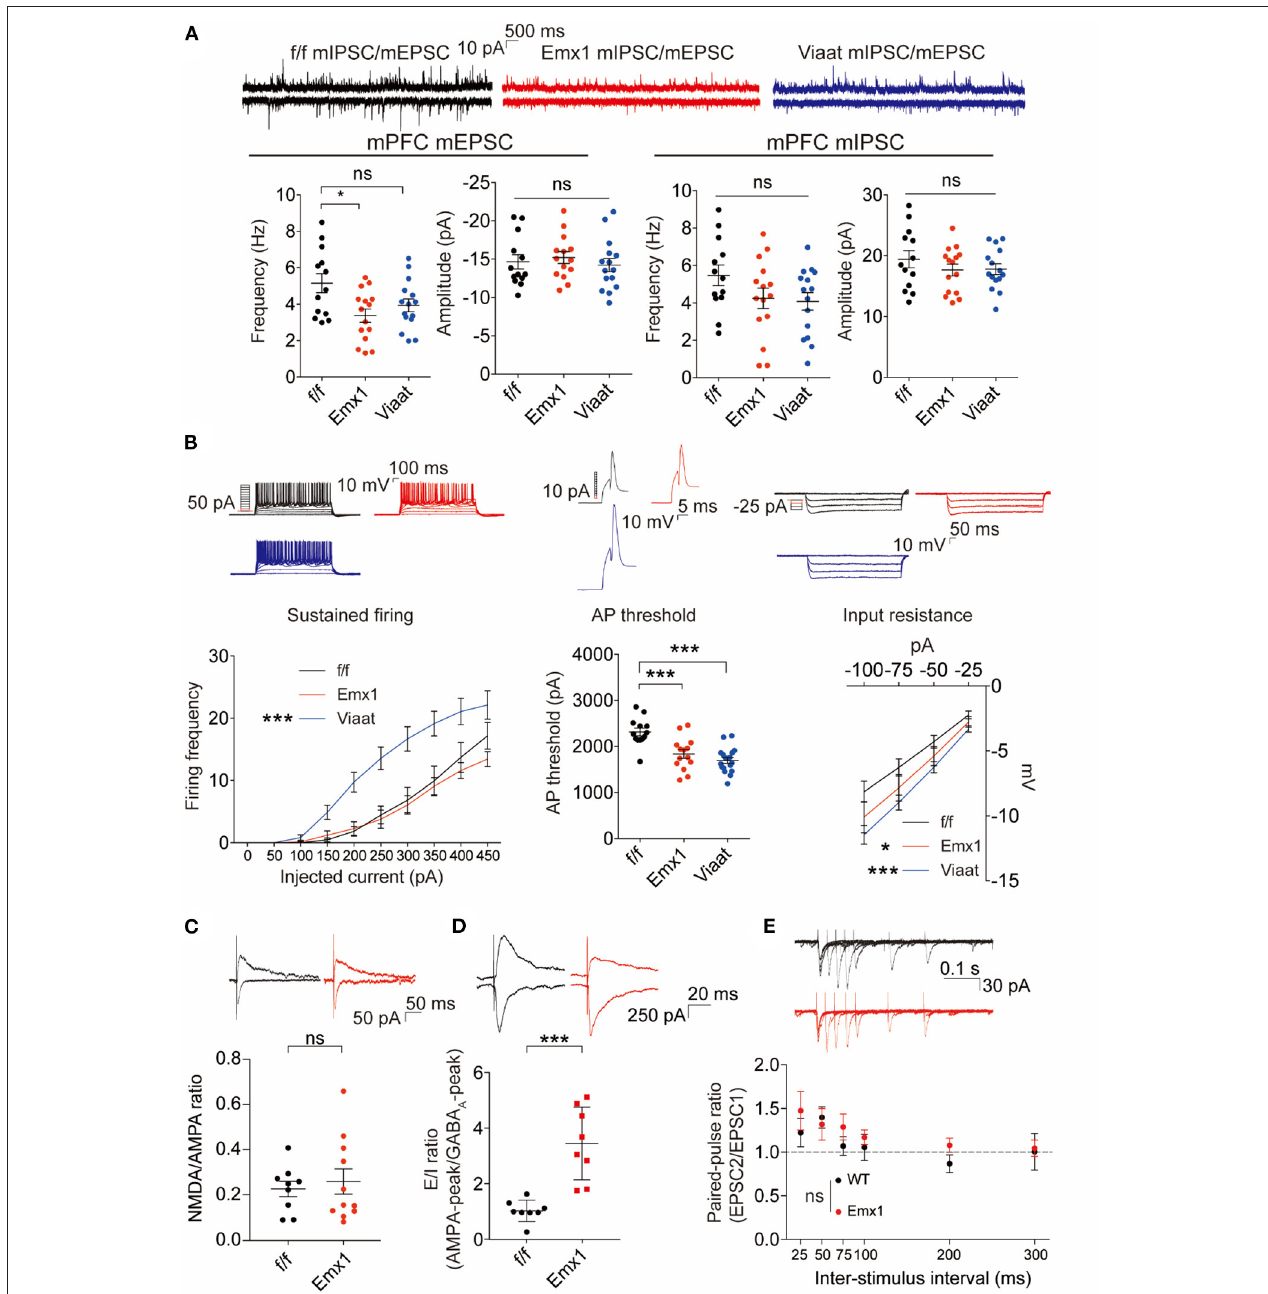
FIGURE 3 | Emx1-Cre;Irsp53 fl / fl and Viaat-Cre;Irsp53 fl / fl mice show distinct changes in synaptic transmission and intrinsic excitability in medial prefrontal cortex (mPFC) pyramidal neurons. (A) Miniature excitatory postsynaptic currents (mEPSCs) and miniature inhibitory postsynaptic currents (mIPSCs) in layer V pyramidal neurons in the prelimbic region of the mPFC in Emx1-Cre;Irsp53 fl / fl and Viaat-Cre;Irsp53 fl / fl mice (3 months; male). Note that the frequency of mEPSCs is significantly decreased in Emx1-Cre;Irsp53 fl / fl mice. n = 13 neurons from three mice for f/f-mEPSC, 14, 3 for Emx1-mEPSC, 15, 3 for Viaat-mEPSC, 13, 3 for f/f-mIPSC, 15, 3 for Emx1-mIPSC, and 15, 3 for Viaat-mIPSC, * P < 0.05, ns, not significant, one-way ANOVA with Bonferroni’s test. mEPSC frequency, F (2, 39) = 4.119; mEPSC amplitude, F (2, 39) = 0.342; mIPSC frequency, F (2, 40) = 2.012; mIPSC amplitude, F (2, 40) = 0.7806. (B) Intrinsic excitability in layer V pyramidal neurons in the prelimbic region of the mPFC in Emx1-Cre;Irsp53 fl / fl and Viaat-Cre;Irsp53 fl / fl mice (3 weeks; male). Note that intrinsic excitability is increased both in Emx1-Cre;Irsp53 fl / fl and Viaat-Cre;Irsp53 fl / fl mice. n = 13, 3 for f/f-firing frequency, 14, 3 for Emx1-firing frequency, 18, 3 for Viaat-firing frequency, 13, 3 for f/f-AP threshold, 14, 3 for Emx1-AP threshold, 18, 3 for Viaat-AP threshold, 13, 3 for f/f-input resistance, 14,3 for Emx1-input resistance, 18, 3 for Viaat-input resistance, * P < 0.05, *** P < 0.001; ns, not significant, one-way ANOVA with Bonferroni’s test for AP threshold, two-way ANOVA with Bonferroni’s test for firing frequency and input resistance. Sustained firing, interaction F (18, 420) = 3.165, current F (9, 420) = 61.89, genotype F (2, 420) = 56.73; action potential threshold, F (2, 42) = 16.14; input resistance, interaction F (6, 168) = 0.5088, current F (3, 168) = 60.88, genotype F (2, 168) = 11.33. (C) Normal ratio of evoked N-methyl-D-aspartate receptors (NMDAR)-EPSCs and AMPA receptor